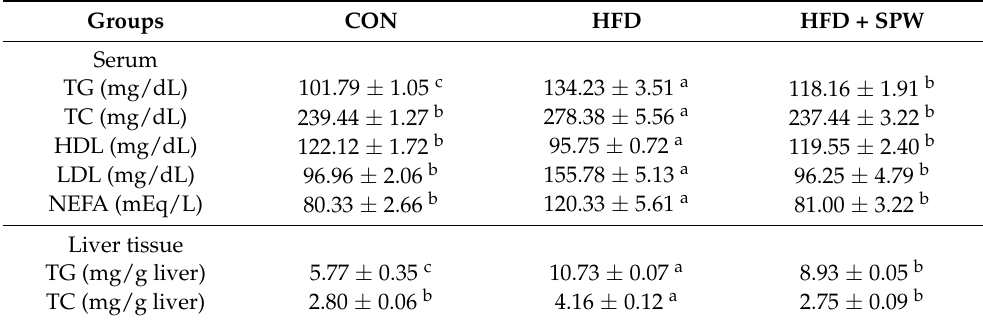
Table 4. Biochemical parameters in HFD-induced NAFLD